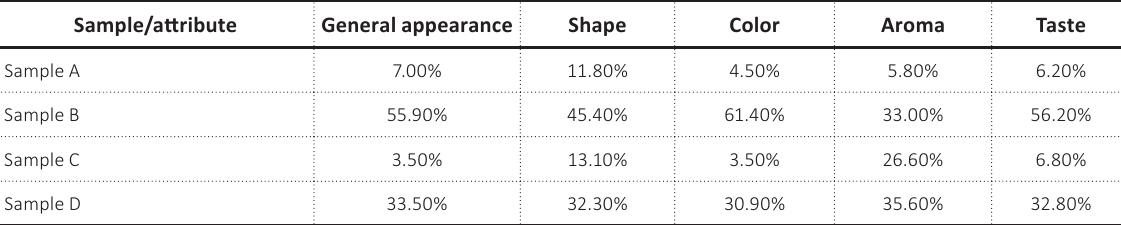
Table 2. Results of blind test of tomatoes by respondents